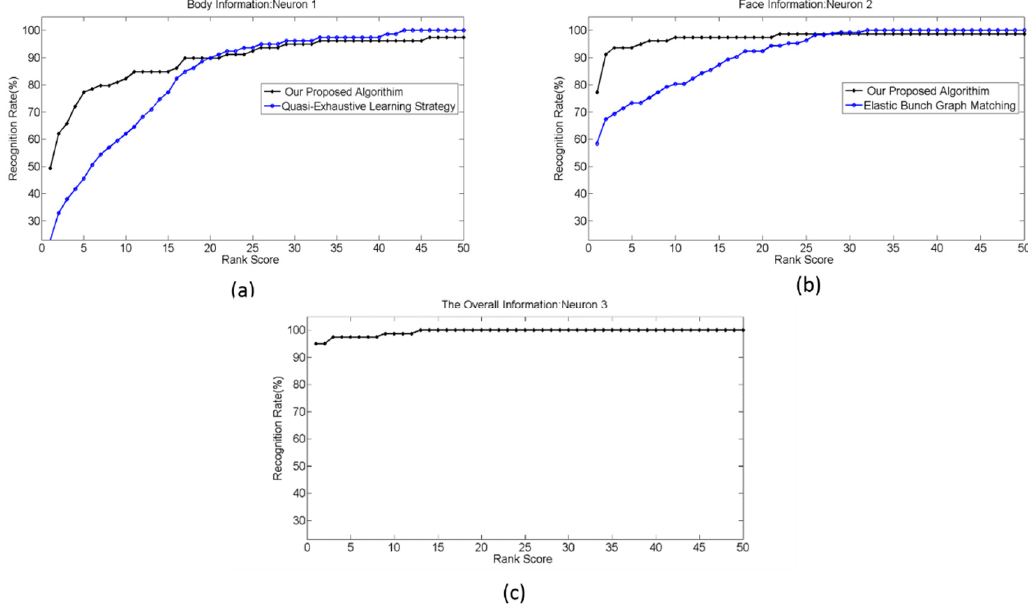
Figure 12. ( a ) CMC based on body information calculated on Walking 2 group vs collaborative group from the RGB-D database, ( b ) CMC based on face information calculated on fb and duplicate II images from the FERET database, and ( c ) CMC based on temporal binding of face and body information where body information is evaluated as described in Figure 12a and face information is evaluated as described in Figure 12b.